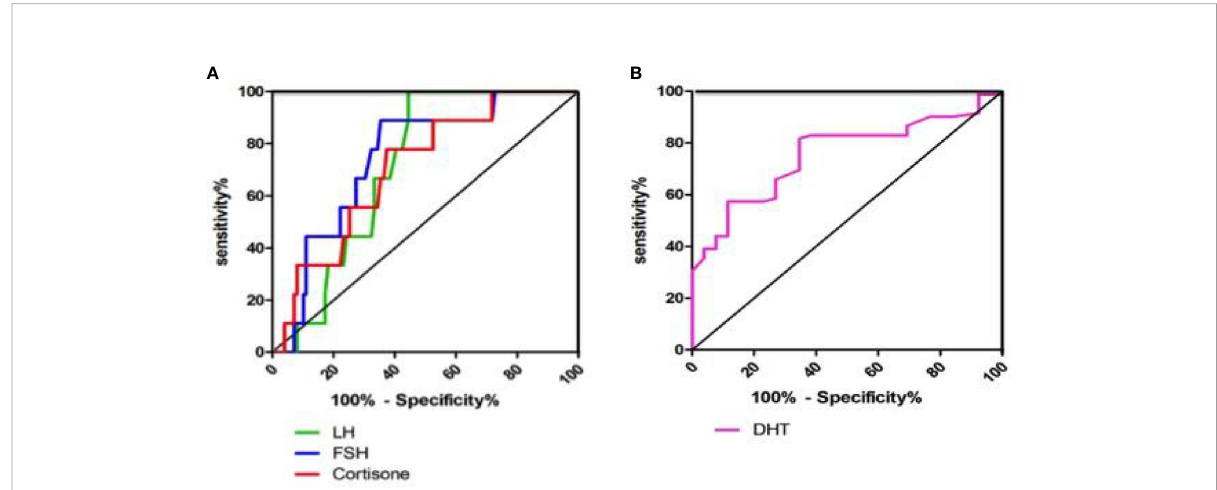
FIGURE 4 Receiver operating characteristic curve analysis of LH, FSH, Cortisone and DHT levels in FF. (A) Receiver operating characteristic curve analysis of LH, FSH and Cortisone levels in FF for top quality embryos on the 5th day from 136 matched embryos; (B) Receiver operating characteristic curve analysis of DHT level in FF for fertilisated embryos from 136 matched